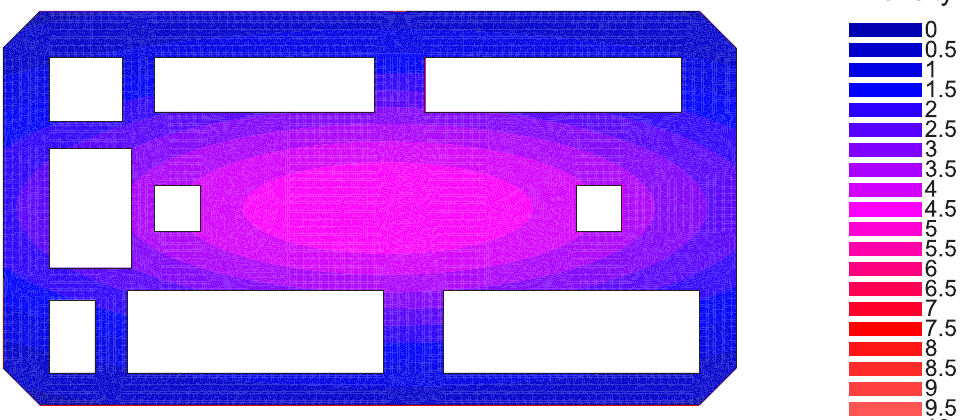
Figure 3. Initial density of pedestrians ρ 0 for the numerical tests: a Gaussian distribution taking maximum value 5 in the central point of the square.